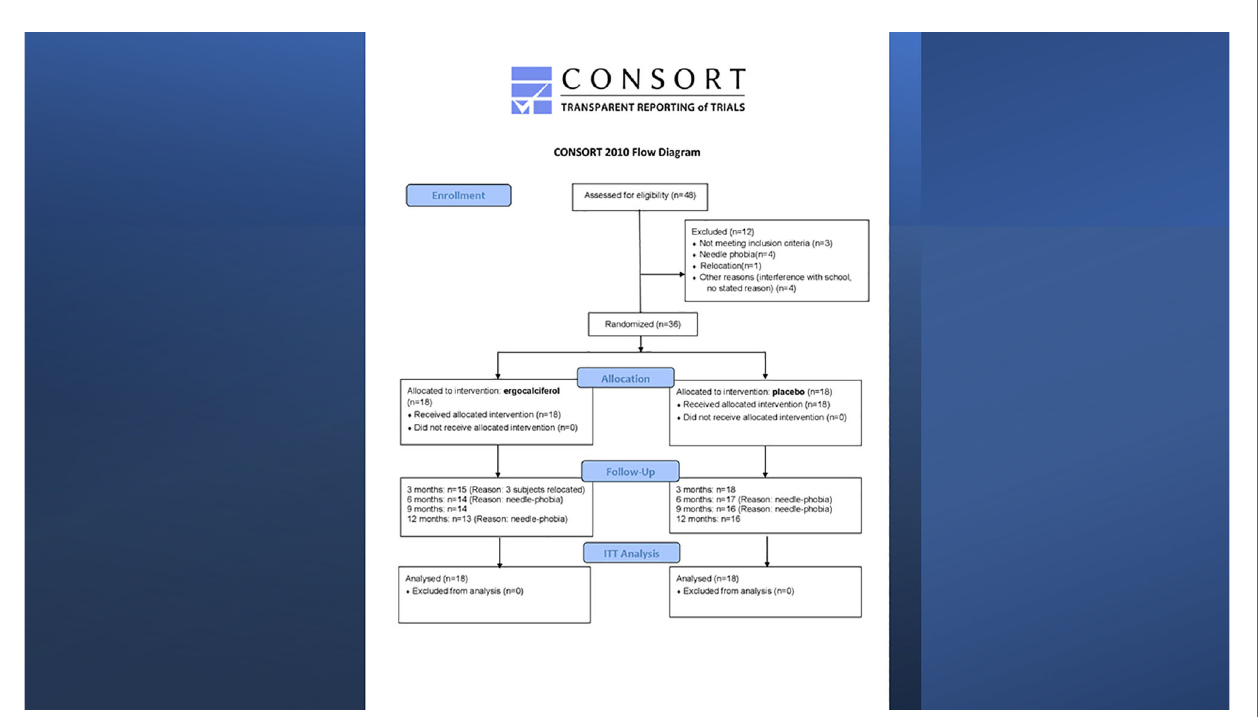
FIGURE 1 | Consort Flow Diagram of randomized controlled trial of ergocalciferol in children and adolescents with newly diagnosed type 1